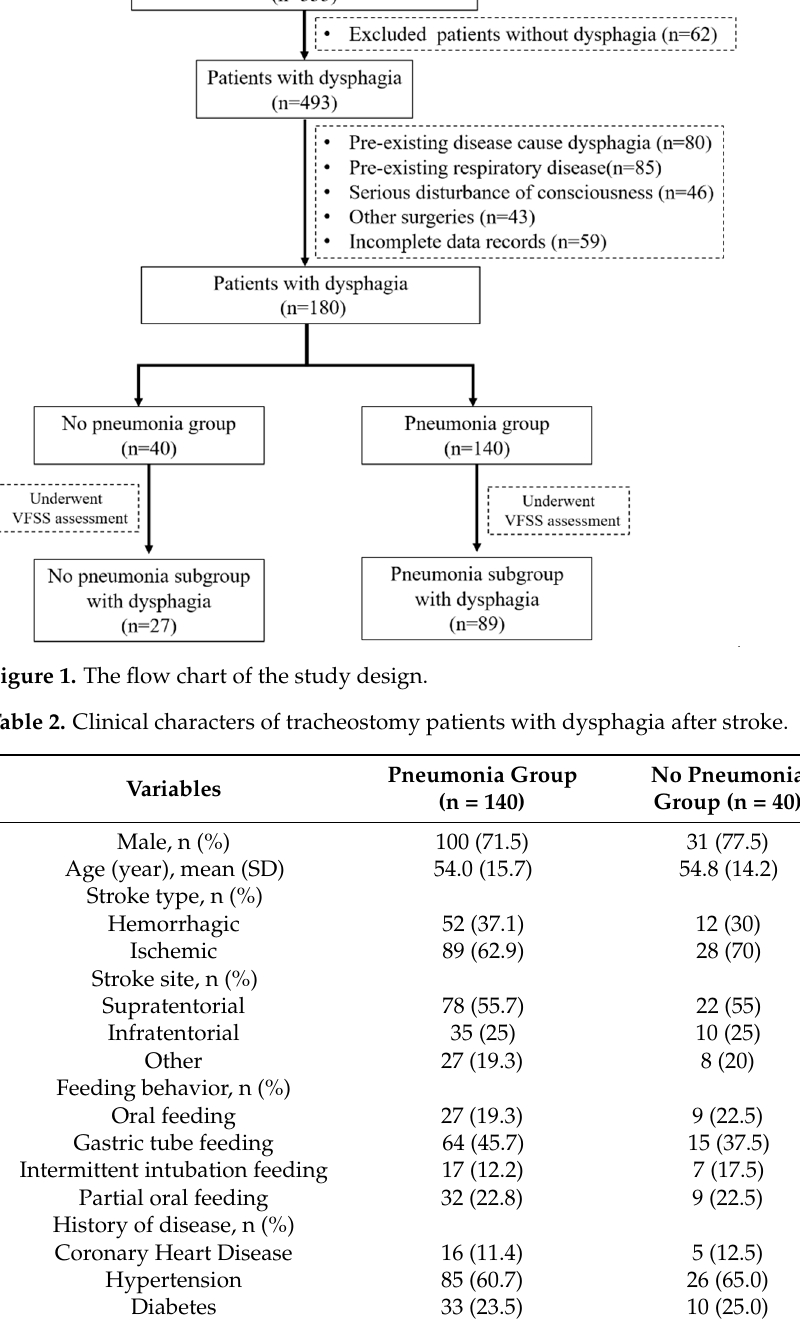
Table 2. Clinical characters of tracheostomy patients with dysphagia after stroke.